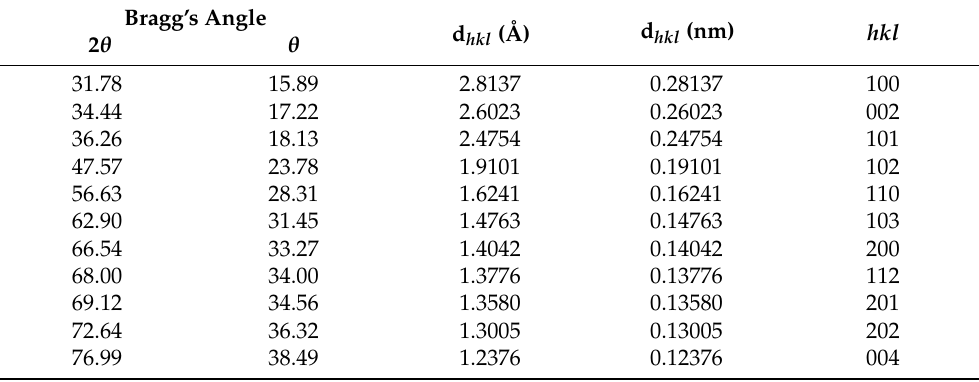
Table 1. Crystal lattice indices, average crystallite size, FWHM and crystallinity of the produced ZnO powders.